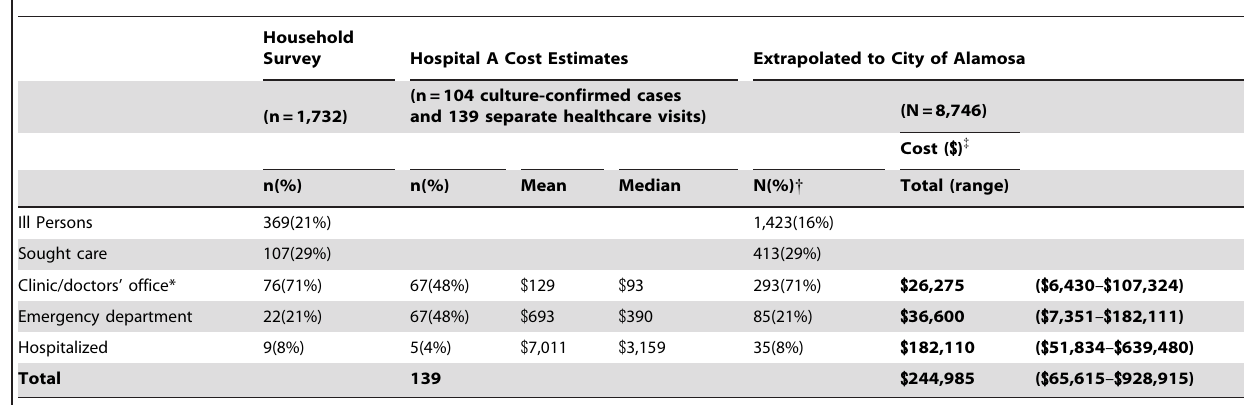
Table 8. Health insurance payments for Alamosa City residents that sought healthcare during an outbreak of salmonellosis, Alamosa, Colorado